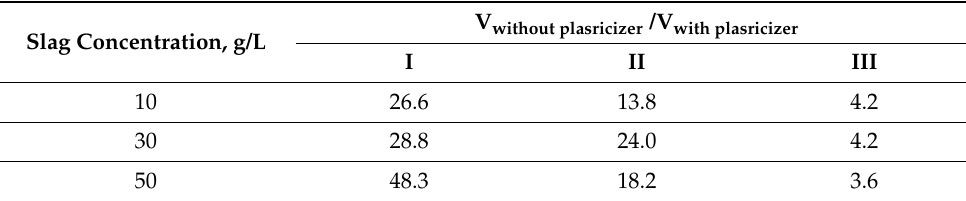
Table 12. Comparative analysis of the sedimentation rates of slag in water and water-polymer dispersed medium.